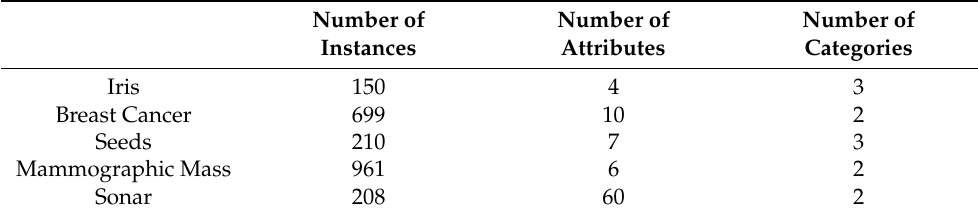
Table 2. Data Set